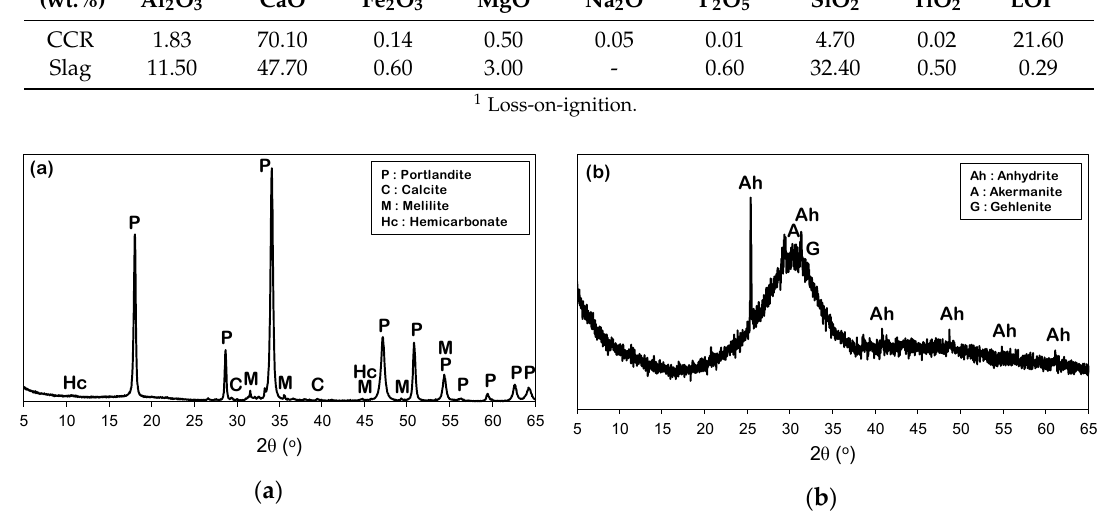
Figure 1. X-ray diffractograms of ( a ) CCR and ( b ) raw slag. Figure 1. X-ray di ff ractograms of ( a ) CCR and ( b ) raw